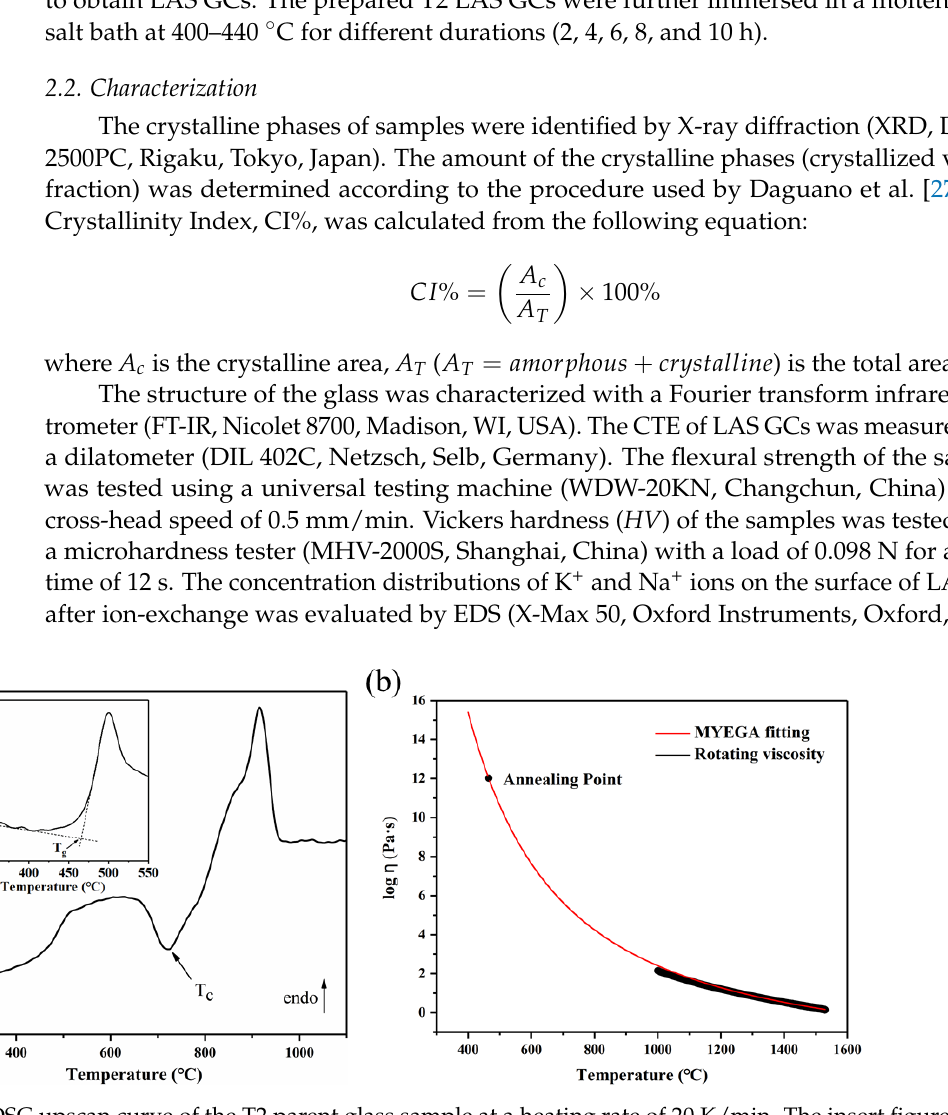
Figure 1. ( a ) The first DSC upscan curve of the T2 parent glass sample at a heating rate of 20 K/min. The insert figure is the second upscan curve followed by a cooling rate of 10 K/min (to determine T g ); ( b ) viscosity of T2 parent glass sample measured by the rotation method. The viscosity data were fitted by the MYEGA equation.